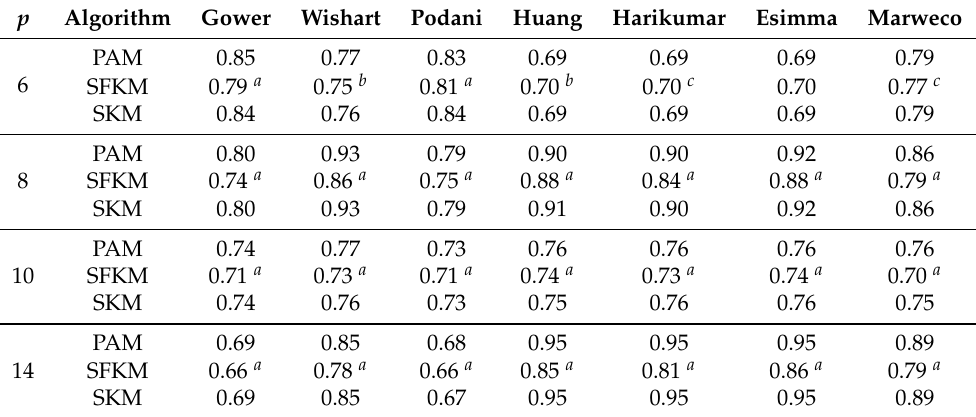
Table 6. Rand indices of the different numbers of